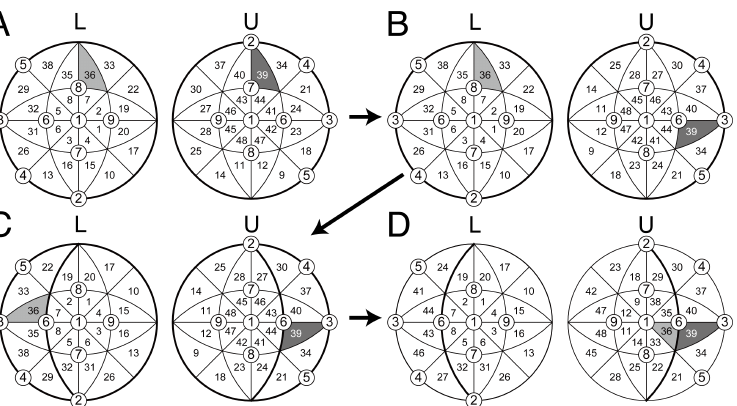
Figure 9. Representation of sequential rotations of the hemispheres of C8. L stands for “lower”, and U for “upper”.